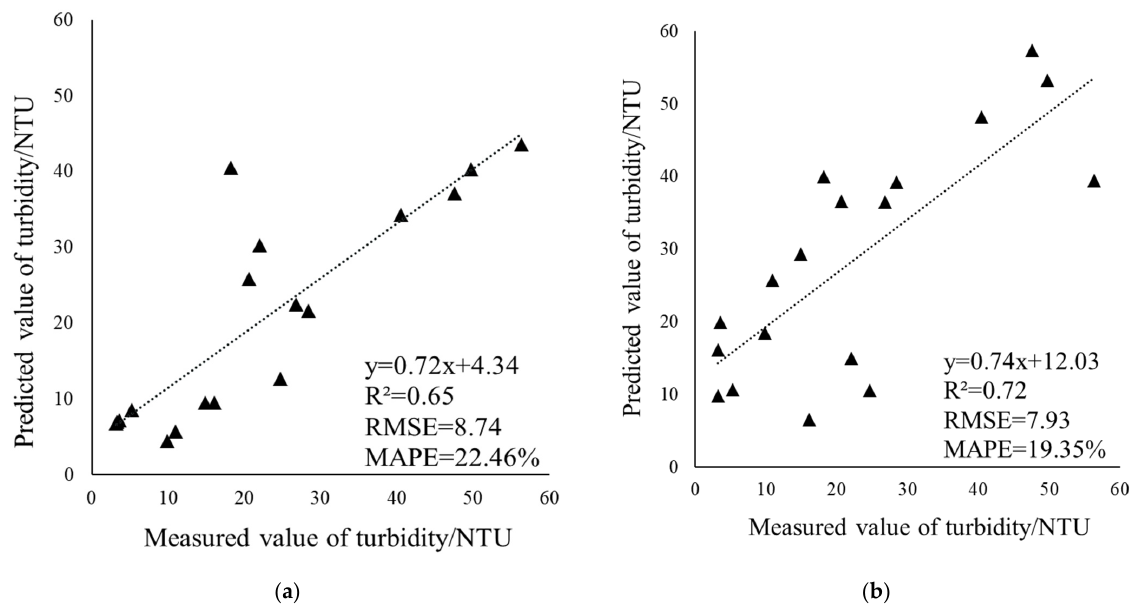
Figure 8. Analysis of the predicted value of turbidity retrieval, ( a ) is the result of hyperspectral band ratio model; ( b ) is the result of PLS Hyperspectral retrieval model.